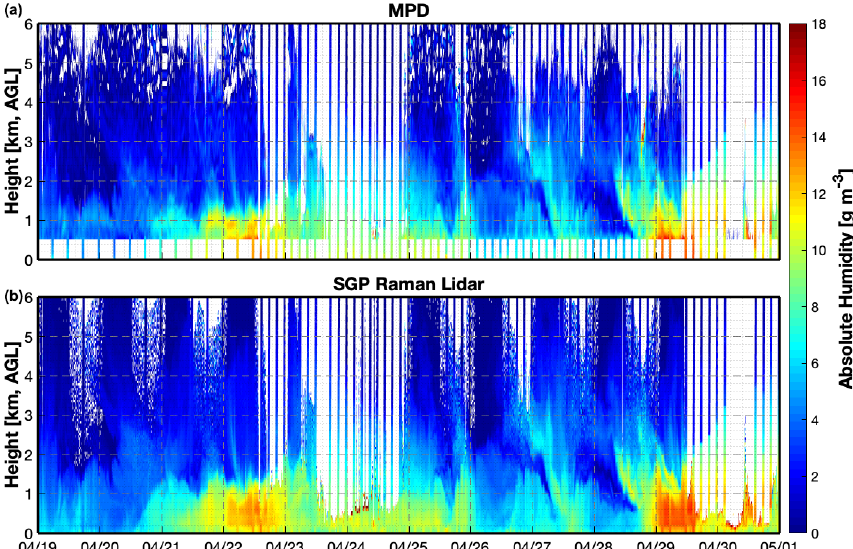
Figure 2. Twelve days of data from the MPD Network Demonstration field test. Absolute humidity from 0–6kma.g.l. as measured by the Gen 4 version (prior to upgrade to Gen 5) of the MPD05 unit without a near-range channel (a) and the SGP Raman lidar (b) . Both Raman and MPD data are at 10min temporal resolution. The radiosonde absolute humidity data are overlaid on both plots.